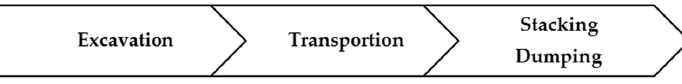
Figure 8. The sub-process of the continuous mining system.